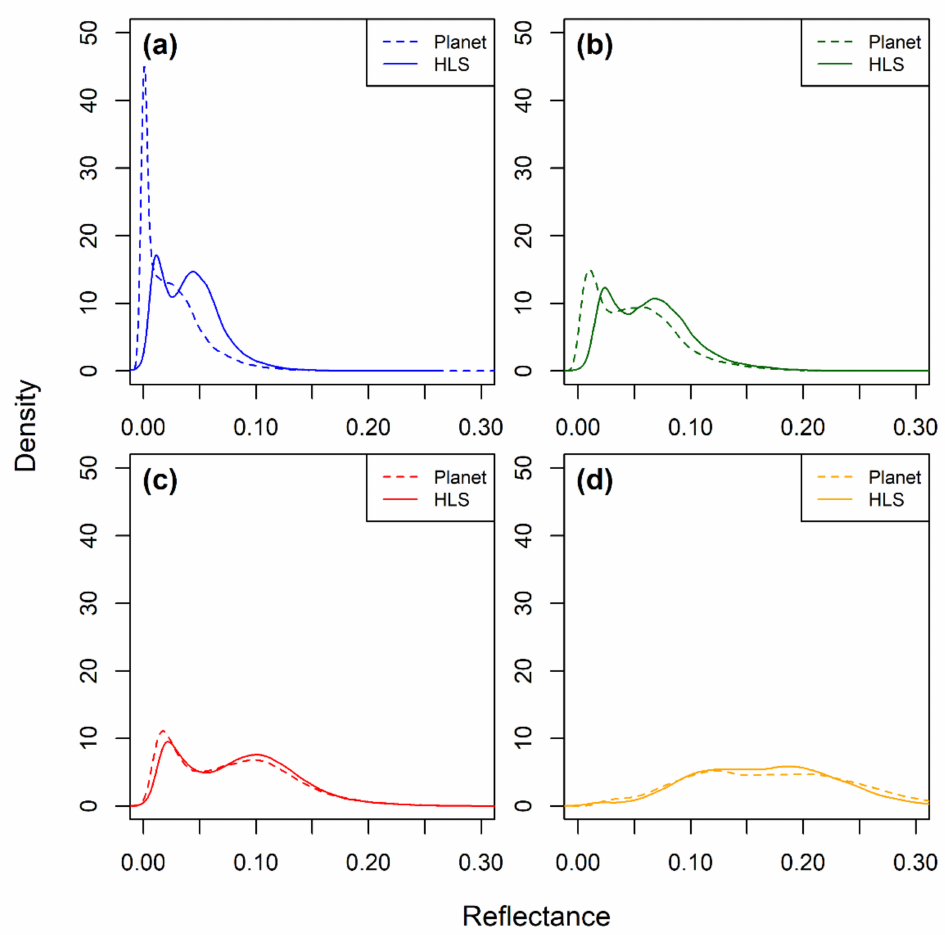
Figure 3. Density plots of Planet (dashed lines) compared to corresponding Harmonized Landsat Sentinel-2 (HLS) (solid lines) for ( a ) blue, ( b ) green, ( c ) red, and ( d ) nir bands. Data were derived from a scene captured on 8 October 2020 in western Colorado, USA [38.88N, −